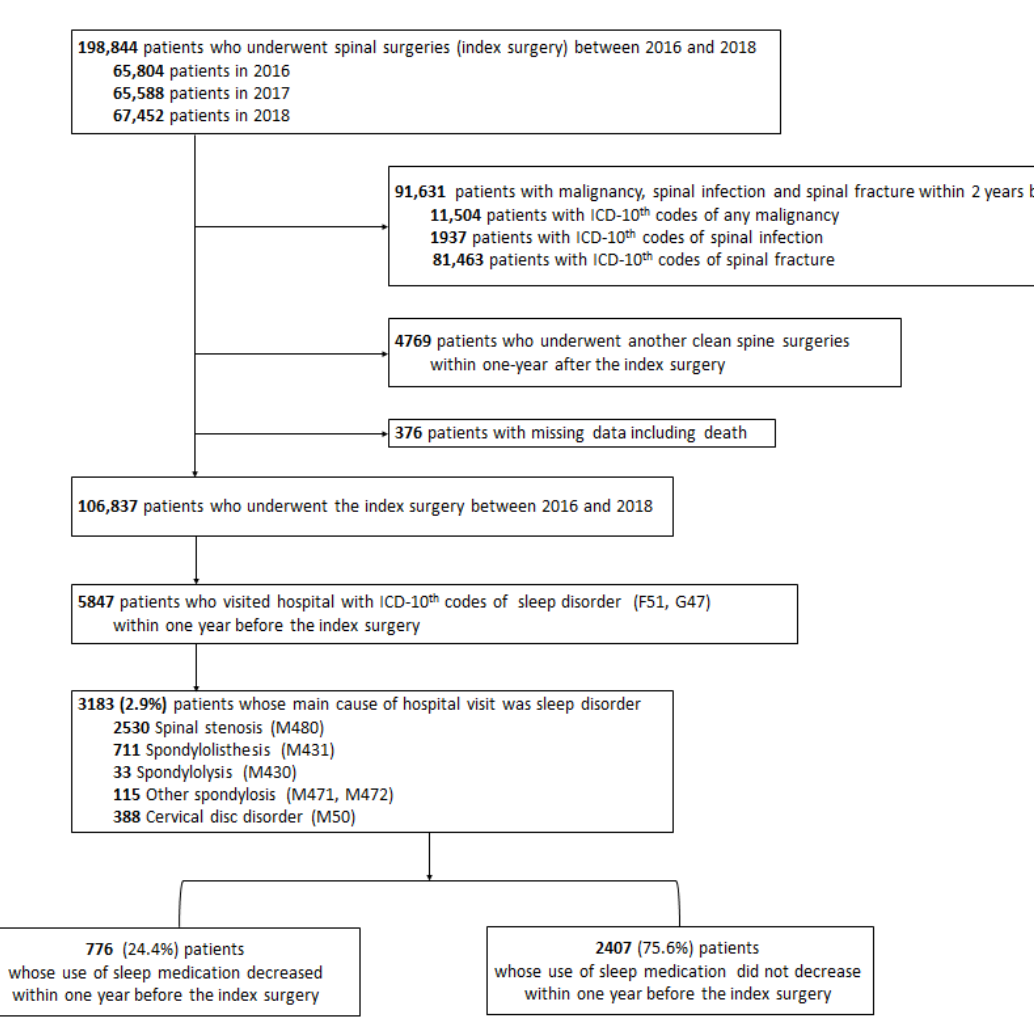
Figure 1. Patient